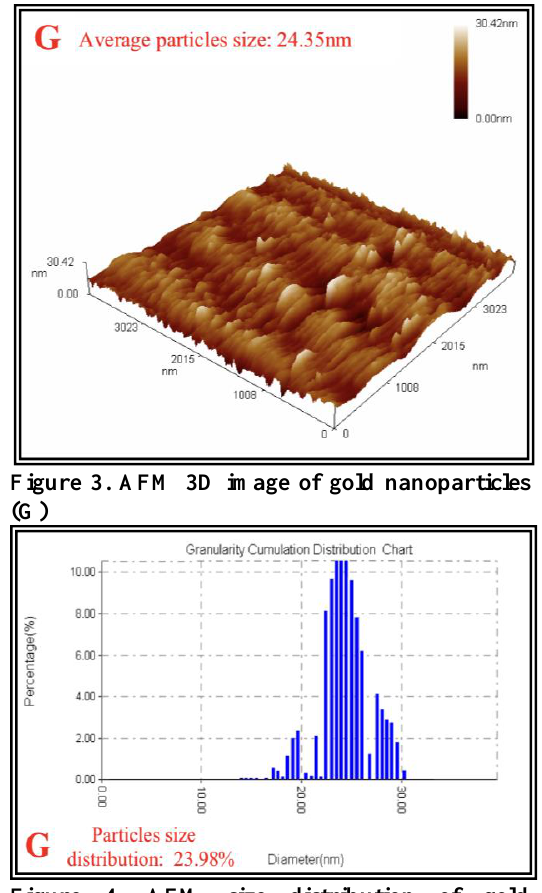
Figure 4. AFM size distribution of gold nanoparticles (G) Optimization of gold